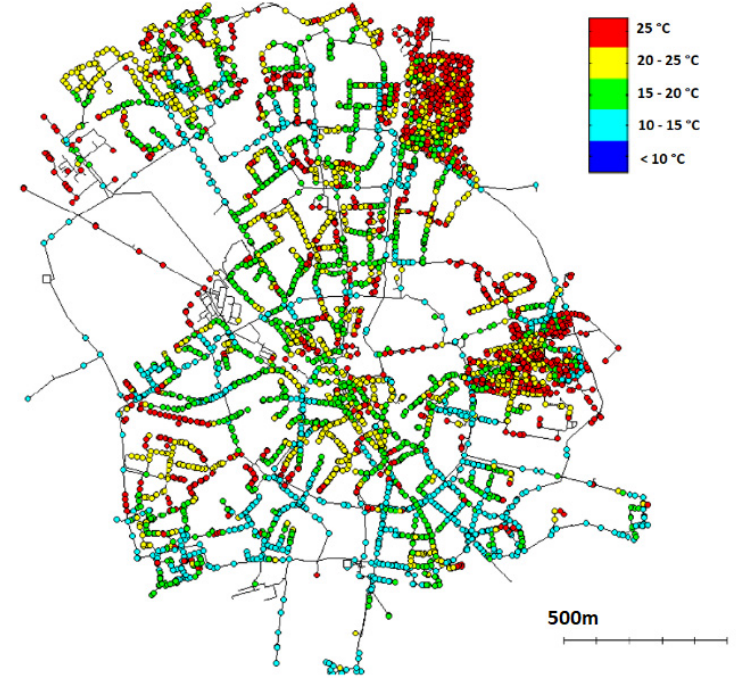
Figure 3. Example of simulation of the temperature in the DWDS [10].